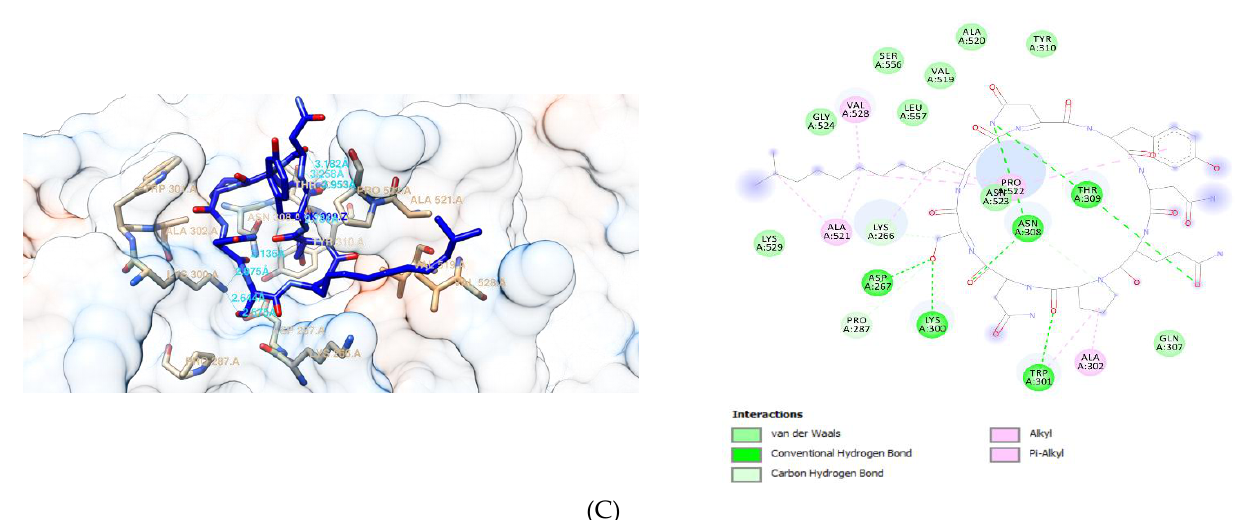
Figure 2. Molecular interaction between PBP1 with ( A ) fengycin, ( B ) surfactin, and ( C ) iturin A.